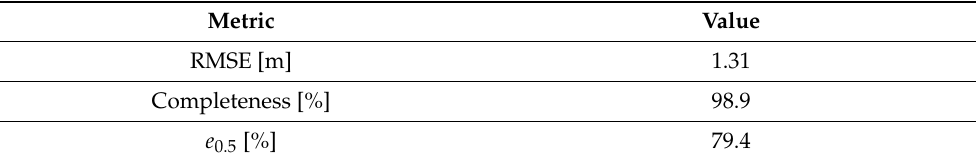
Table 2. Validation of the obtained results from the comparison with ISPRS benchmark data.